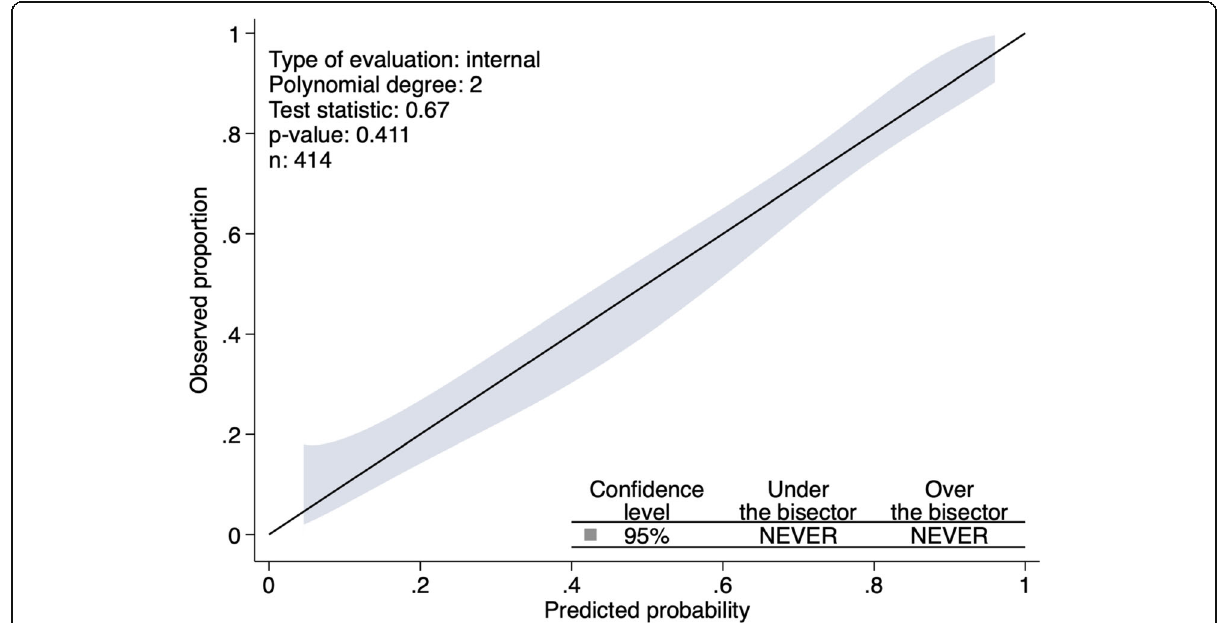
Fig. 1 Calibration curve for predictive model for success of TESE. Relationship between the calculated and observed sperm retrieval